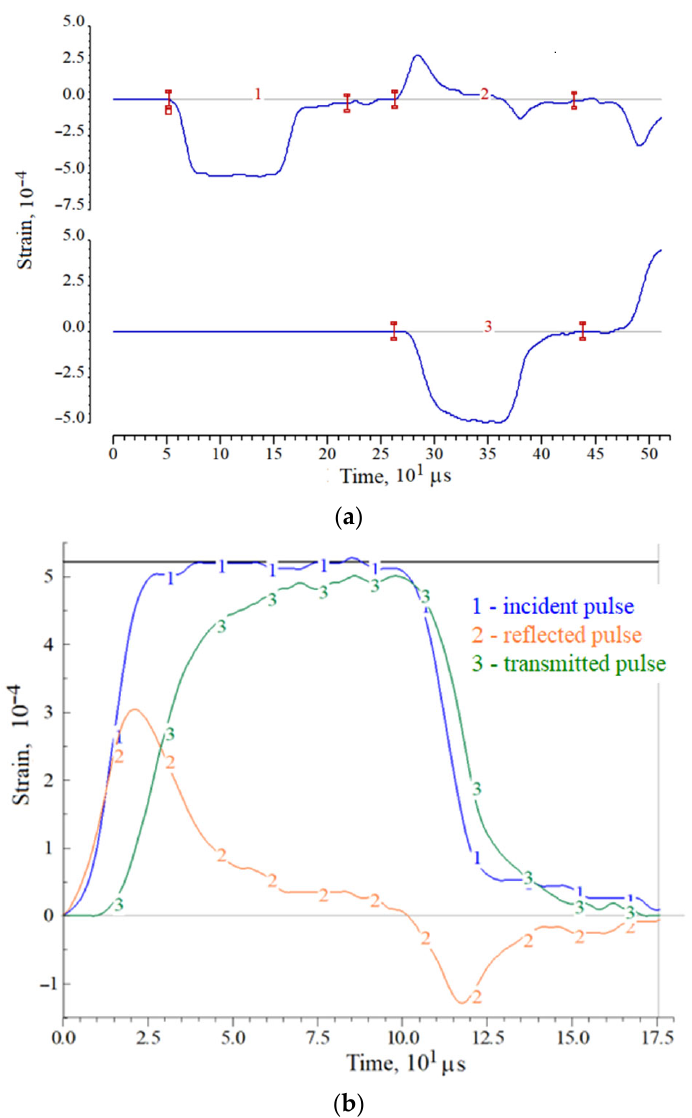
Figure 2. An example of strain pulses in measuring bars during registration ( a ) and during synchronization ( b ) when testing a ceramic specimen maintaining its visible integrity.